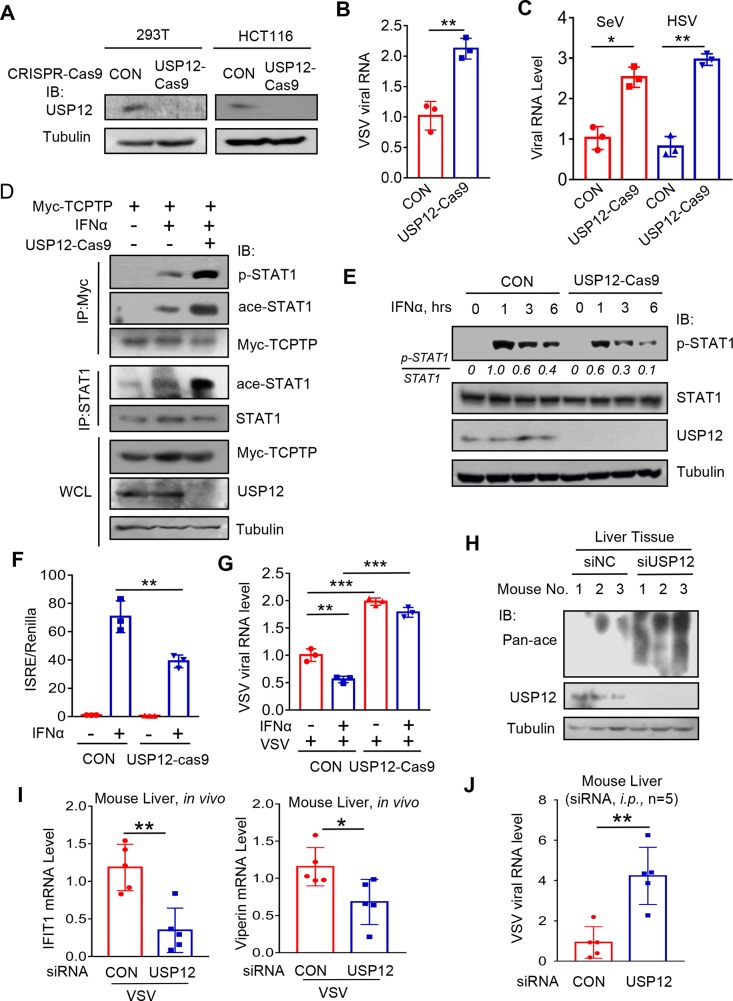
USP12 deficiency attenuates IFN signaling and antiviral activity.(A) Western blot analysis of endogenous USP12 levels in USP12+/+(CON) or USP12-/-(USP12-Cas9) HEK293T cells or HCT116 cells made by the CRISPR-Cas9-mediated genome editing. (B) USP12+/+(CON) or USP12-/-(USP12-Cas9) HEK293T cells were infected with VSV (MOI = 0.5) for 20 hrs. Viral RNA levels were analyzed by Q-PCR. (C) USP12+/+(CON) or USP12-/-(USP12-Cas9) HCT116 cells were challenged with SeV (MOI = 0.5, 20 hrs) or HSV (MOI = 1.0, 8 hrs). Viral RNA levels were analyzed by Q-PCR. (D) Immunoprecipitation analysis of the interaction between p-STAT1, ace-STAT1 and Myc-TCPTP in USP12+/+(CON) or USP12-/-(USP12-Cas9) HEK293T cells transfected with Myc-TCPTP and then treatment with IFNα (1,000 IU/ml) for 2 hrs. (E) Western blot analysis of p-STAT1 levels in USP12+/+(CON) or USP12-/-(USP12-Cas9) HEK293T cells stimulated with IFNα (1,000 IU/ml) for 0, 1, 3, 6 hrs. (F) USP12+/+(CON) or USP12-/-(USP12-Cas9) HEK293T cells were transfected with ISRE-Luc and Renilla. The luciferase activity was measured 20 hrs after IFNα (1,000 IU/ml) treatment. (G) Q-PCR analysis of viral RNA levels in USP12+/+(CON) or USP12-/-(USP12-Cas9) HEK293T cells pretreated with IFNα (30 IU/ml) overnight and then challenged by VSV (MOI = 1.0) for 20 hrs. (H) Mice (N = 3, per group) were administrated with either negative control siRNAs (siNC) or siRNAs against mouse USP12 (siUSP12) by tail vein injection. Western blot analysis of USP12 protein levels and the pan-acetylation levels in mouse livers as indicted. (I and J) Mice (N = 5, per group) were injected with siNC or siUSP12 twice (once per day). 48 hrs after initial injection, mice were infected with VSV (2X108 pfu per mouse) for 24 hrs. The representative ISGs (IFIT1, Viperin) mRNA (I) or Viral RNA (J) levels in mouse liver tissues were analyzed by Q-PCR. *p<0.05, **p<0.01 and ***p<0.001 (two-tailed unpaired Student’s t-test). Data are shown as mean and s.d. of three biological replicates (B, C, F, G, I, J).